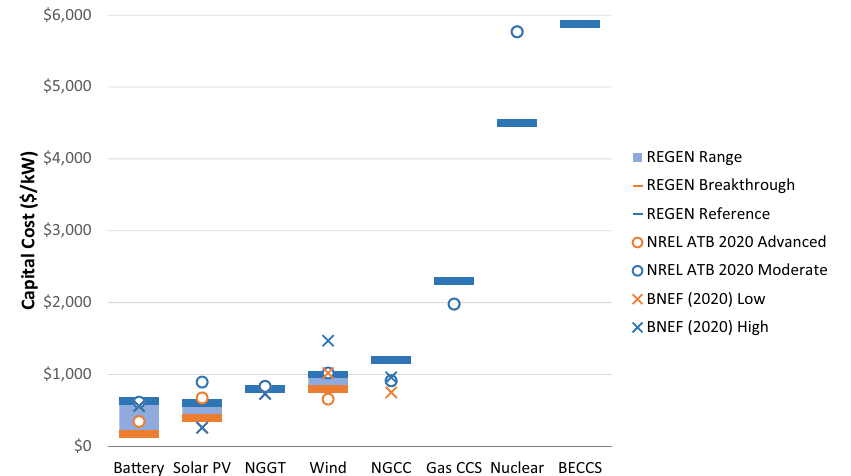
Fig. 1 Capital cost assumptions (2018 USD per kW capacity) by technology in REGEN. REGEN values come from EPRI ’ s Integrated Technology Generation Options report 26 and expert elicitations. Reference assumptions are shown in blue, and breakthrough (i.e., low cost) assumptions are shown in orange for batteries, solar, and wind. Comparisons are provided with NREL ’ s 2020 Electricity Annual Technology Baseline (ATB) 61 and BloombergNEF ’ s “ Levelized Cost of Electricity 2H 2020 ” 62 . Solar costs are expressed in $/kW AC terms. Battery costs in $/kW terms are shown for a 4-h duration system. Additional assumptions are discussed in the “ Methods ” section, Supplementary Note 1, and EPRI 23 . Source data are provided as a Source Data fi le. Table 1 Assumptions for CDR technologies in this analysis.